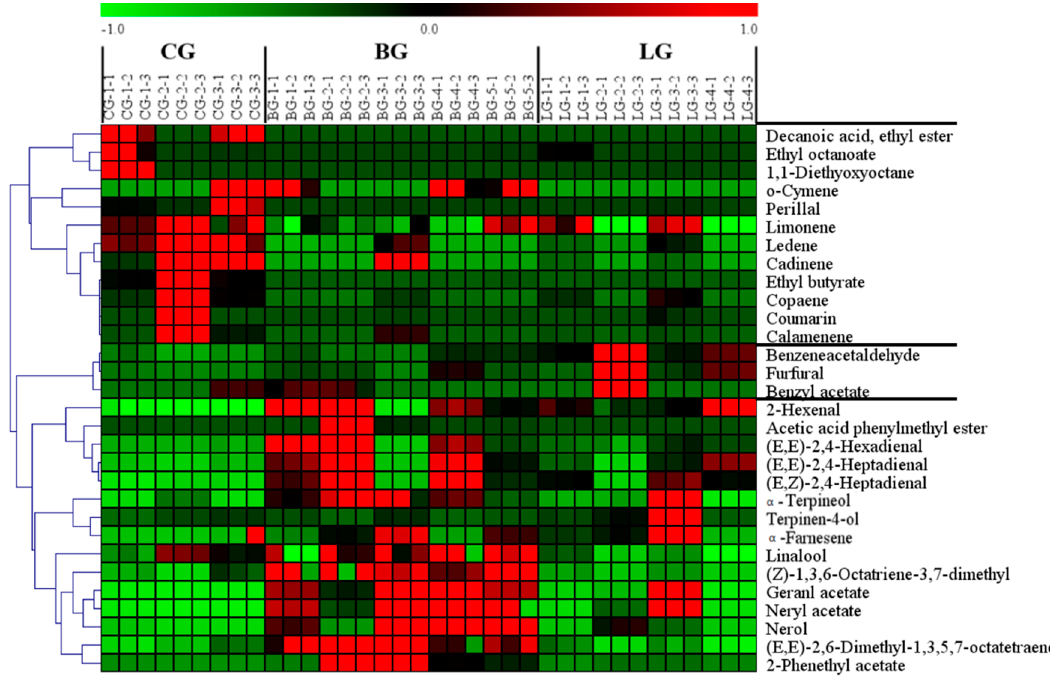
Figure 3. Heat map of contents of key differential volatile compounds among three groups of citrus blend black tea.